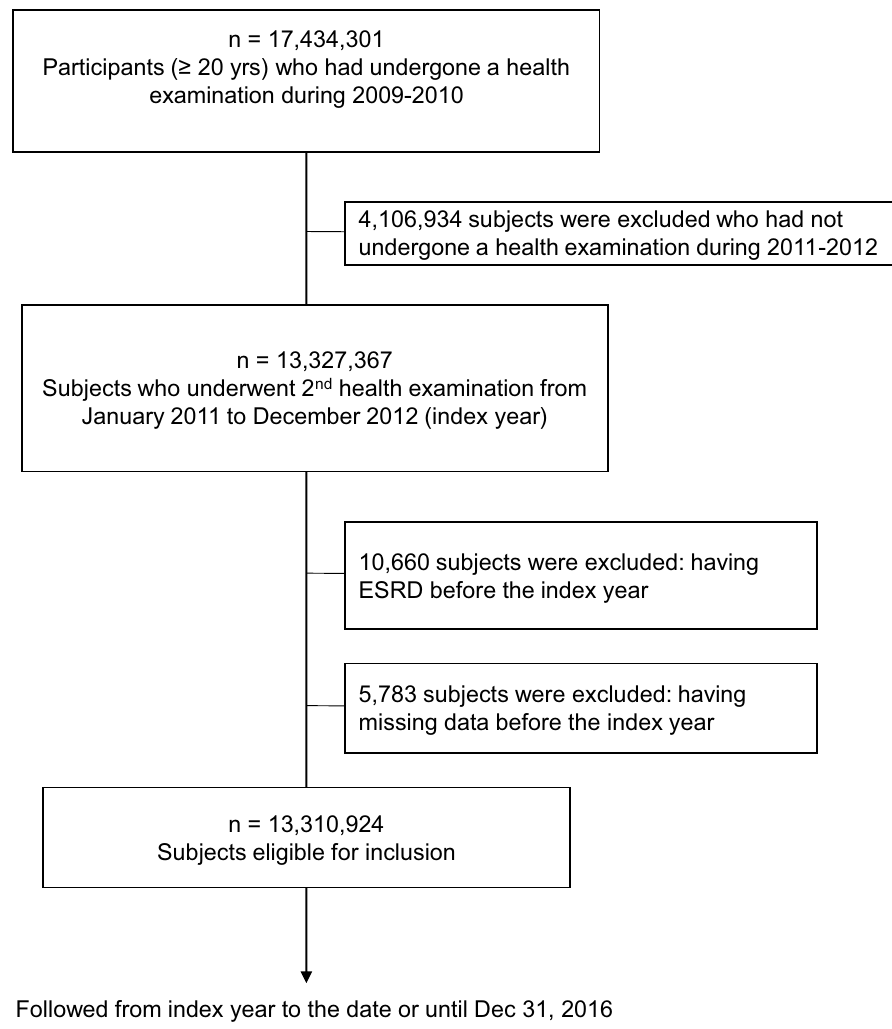
Figure 1. Study enrolment